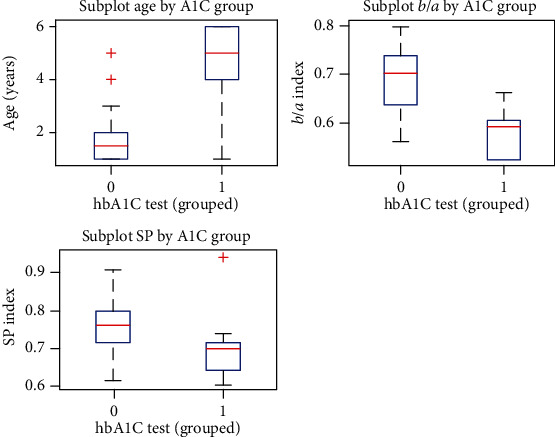
Multiple boxplots for age, b/a, and SP indices grouped by the A1C test, respectively, where 0 represents nondiabetic and 1 represents diabetic.